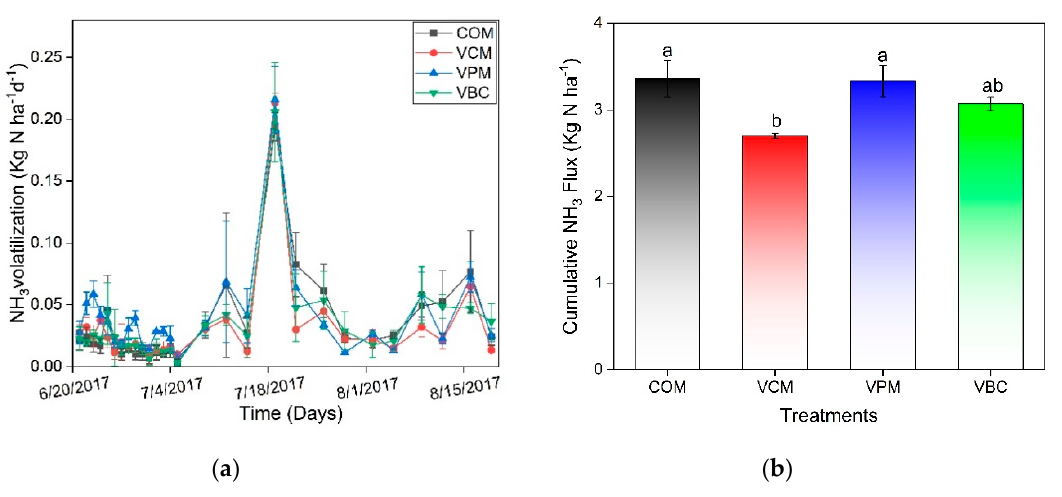
Figure 5. NH 3 volatilization ( a ) and cumulative NH 3 flux ( b ) in all treatments of three replicates. Error bars represent standard errors. Different letters indicate significant differences among the treatments ( p < 0.05).